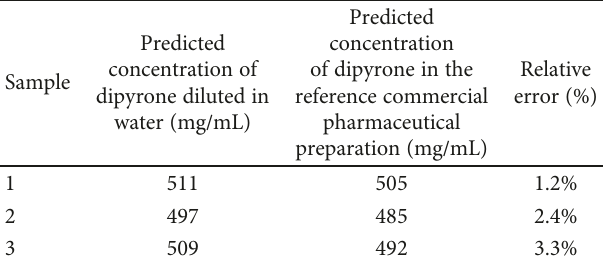
Table 2: Predicted concentrations of dipyrone 500mg/mL in water and in the reference commercial pharmaceutical preparation using the PCR model and the relative errors used to calculate the selectivity.